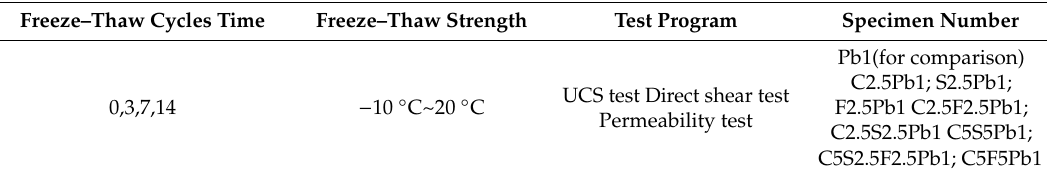
Table 5. Experimental